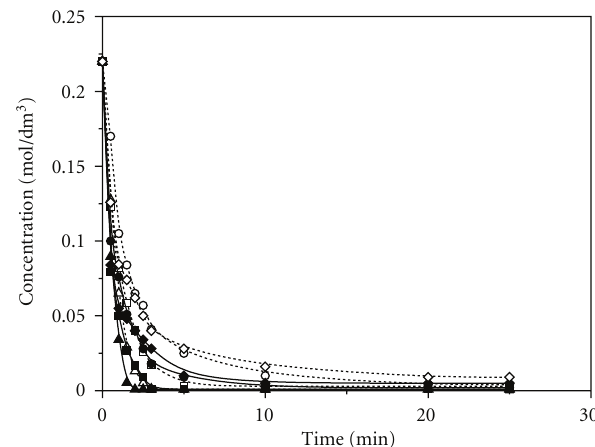
Figure 4: Change of allicin concentration under the influence of microwaves at 45 ◦ C and 55 ◦ C ( (cid:2) Acetonitrile 55 ◦ C; (cid:5) Acetonitrile 45 ◦ C; • Acetone 55 ◦ C; ◦ Acetone 45 ◦ C; (cid:3) Methanol 55 ◦ C; (cid:4) Methanol 45 ◦ C; (cid:4) Chloroform 55 ◦ C; ♦ Chloroform 45 ◦ C).